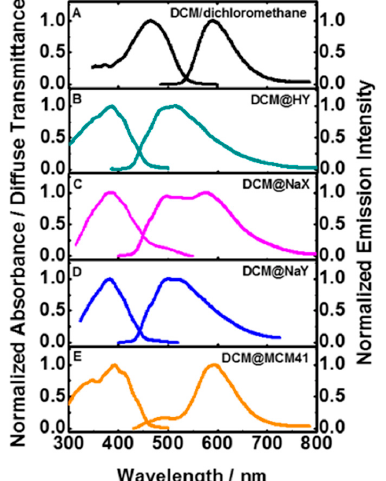
Figure 1. Normalized (to the maximum of intensity) UV-visible absorption/diffuse transmittance and fluorescence spectra of DCM in ( A ) dichloromethane solution and interacting with ( B ) HY, ( C ) NaX, ( D ) NaY zeolites, and ( E ) MCM-41 in dichloromethane suspensions. For all the composites, the initial dye concentration is 1 × 10 − 4 M. For emission, the excitation wavelengths are: 450 nm (for free DCM); 370 nm (for DCM@NaX and DCM@NaY); 380 (for DCM@HY); 340 nm (for